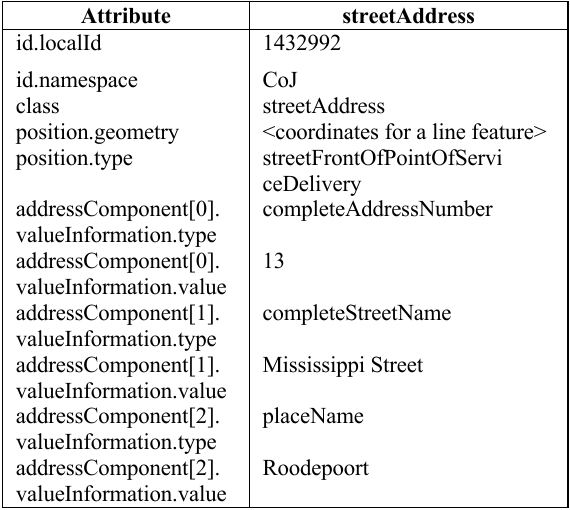
Table 3. An example of a street address object for the City of